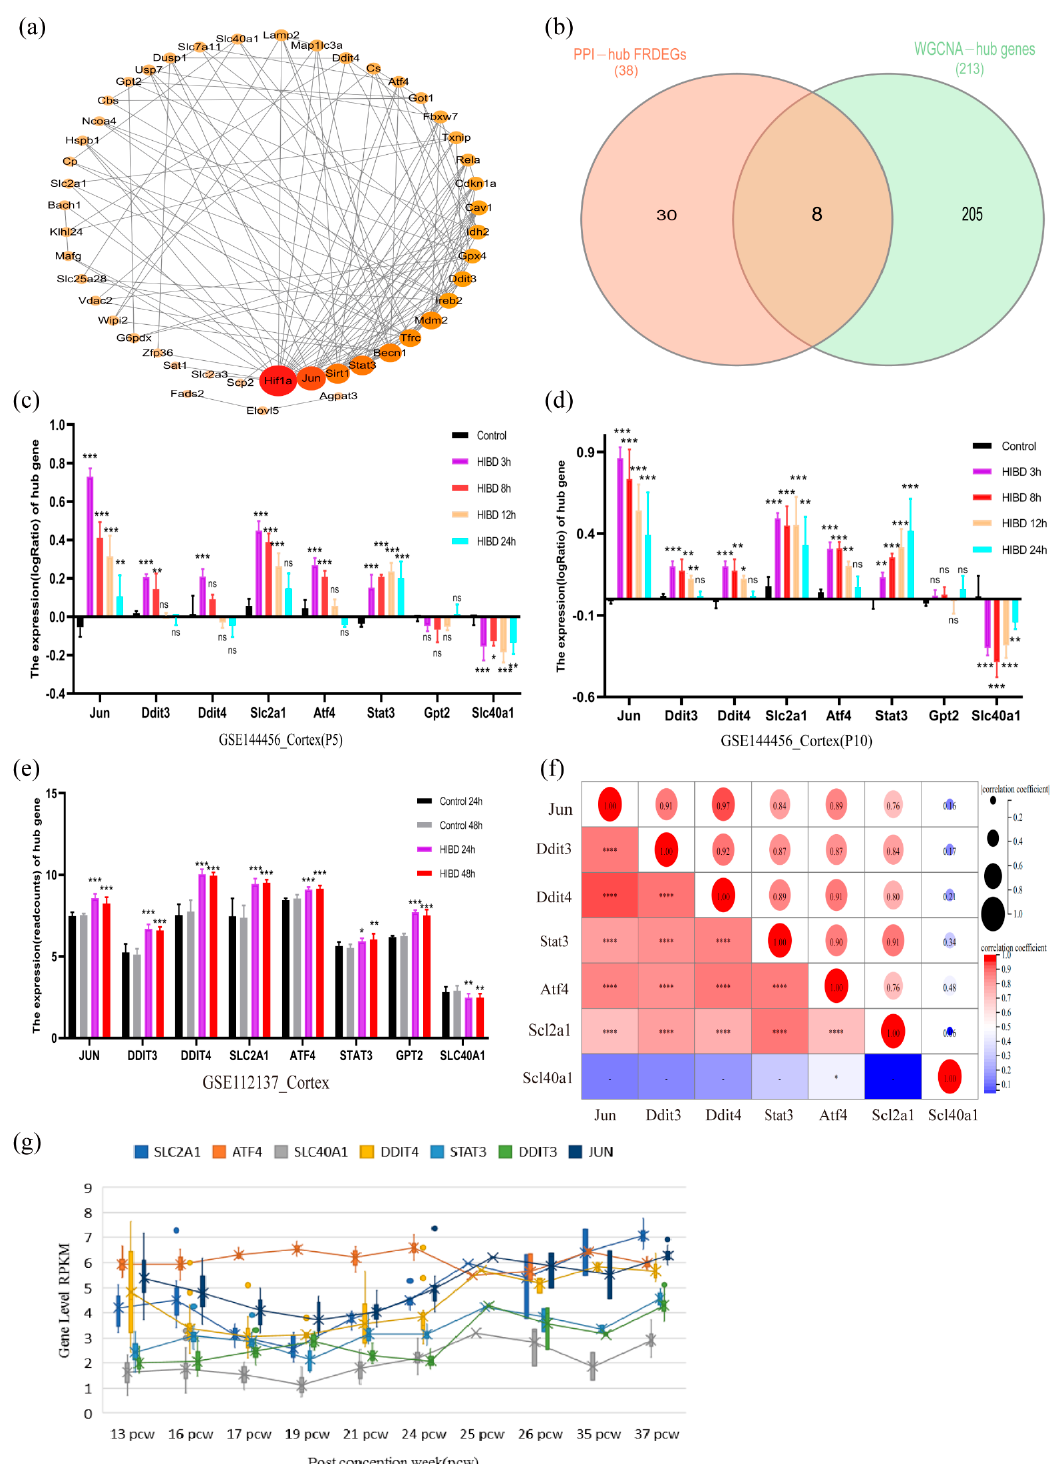
Figure 5. ( a ) PPI network of 56 FRDEGs; ( b ) The screening of the optimal ferroptosis-related genes; ( c , d ) The expression levels of the optimal optimal hub FRDEGs in different ages mouse models; ( e ) The expression levels of the optimal optimal hub FRDEGs in the human cerebral cortex models; ( f ) Correlation analysis of expression patterns of the optimal hub FRDEGs. ( g ) Dynamic expression of the optimal hub FRDEGs in brain tissue development from 13 weeks of gestation (preterm) to 37 weeks of gestational age (full-term). Note: ns ( p > 0.05), * ( p ≤ 0.05), ** ( p ≤ 0.01), *** ( p ≤ 0.001), **** ( p ≤